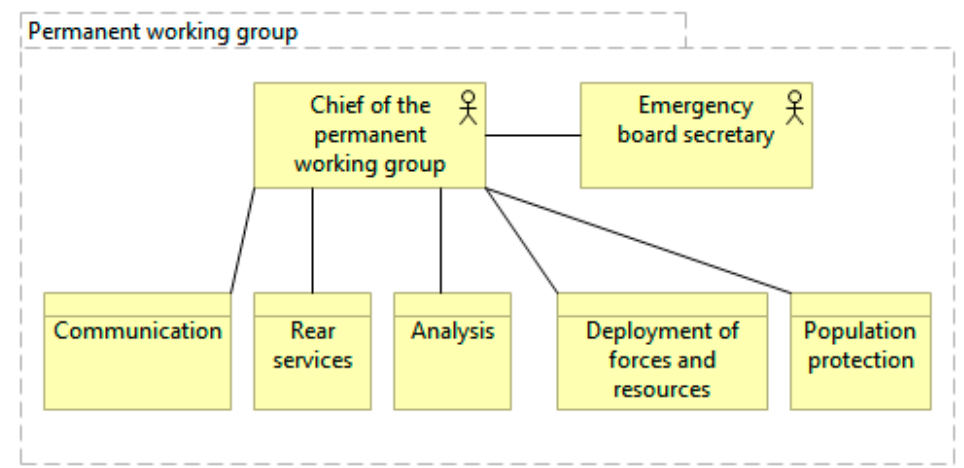
Figure 5. Functional breakdown of the permanent working group.